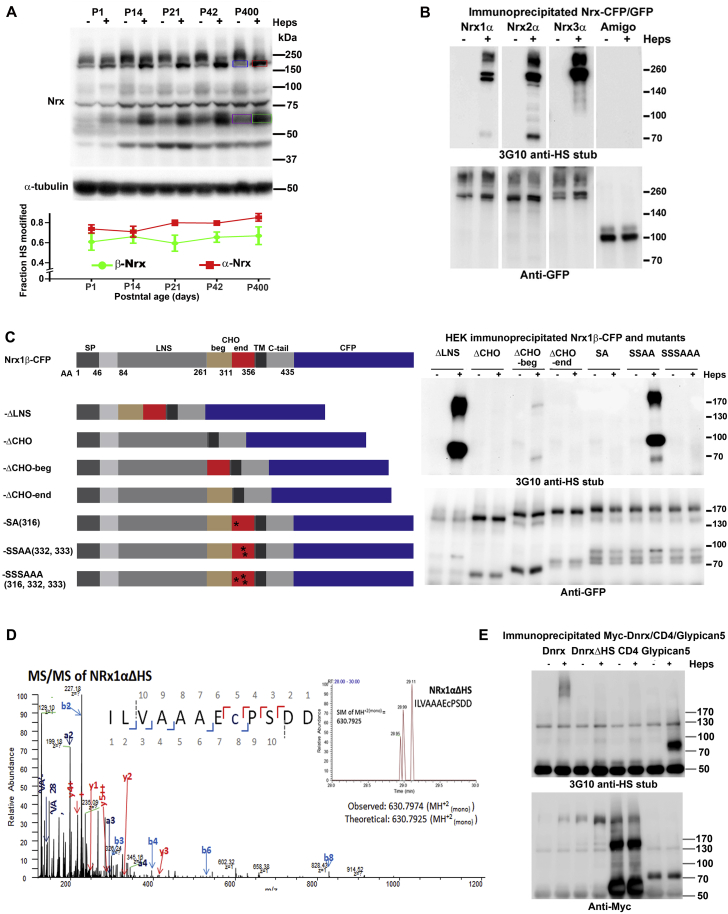
Nrxs Are HSPGs, Related to Figure 1(A) Nrx HS modification throughout development. Crude synaptosome fraction was prepared from mouse brain at the postnatal ages indicated (in days, e.g., P1 is postnatal day 1) and treated or not with heparinase. The extent of Nrx HS modification at each age was estimated from the Nrx immunoblot. For example for P400, the fraction of α-Nrx lacking HS modification was estimated as the integrated signal of unmodified α-Nrx in the untreated sample (blue box) divided by total α-Nrx (red box, condensed band for unmodified α-Nrx after heparinase). Similarly, for P400 the fraction of β-Nrx lacking HS modification was estimated as the integrated signal in the purple box divided by the integrated signal in the green box. In the graph shown, values are reported as fraction of α-Nrx or β-Nrx bearing HS modification. Two-way ANOVA revealed a significant effect of postnatal age (p < 0.05) but posthoc Bonferroni’s pairwise comparisons were not significant, n = 3. Error bars represent SEM.(B) Nrx is poorly HS modified in HEK293 cells in comparison with neurons. All recombinant Nrx fused with GFP or CFP expressed in HEK293 cells are recognized by an HS antibody, indicating some degree of HS modification; 3G10 recognizes the HS stub remaining after heparinase cleavage. However, heparinase treatment resulted in little or no shift in molecular weight, in contrast with the apparent molecular weight shifts of Nrx from the brain or primary neurons (Figures 1A–1C), indicating a deficient modification level in HEK293 cells.(C) Mapping the HS modification site. SP, signal peptide; LNS, laminin neurexin sex hormone binding protein domain; CHO, glycosylated region as previously reported (Reissner et al., 2013); CHO-beg, N-terminal half of the glycosylated region; CHO-end, C-terminal half of the glycosylated region; TM, transmembrane domain; C-tail, cytoplasmic domain; CFP, cyan fluorescent protein; ∗, serine to alanine point mutation. The Nrx1β lacked splice inserts. The constructs were expressed in HEK293 cells and lysate immunoprecipitated with anti-GFP antibody, treated or not with heparinase, then immunoblotted. 3G10 recognizes the HS stub remaining after heparinase treatment. Deletion of the glycosylated region or its C-terminal half or point mutation of serine 316 within this region to alanine (SA(316)) abolished HS modification, while deletion of the N-terminal half of the glycosylated region reduced but did not abolish HS modification.(D) Identification of unmodified peptide from Nrx1αΔHS recombinant protein. MS/MS of peptide ‘ILVAAAEcPSDD’ detected in Nrx1αΔHS. A Selected Ion Monitoring Chromatograph (SIM) of the whole mass at m/z MH+2(mono) 630.7925 with 10ppm mass tolerance is seen in the insert. Fragmentation was produced by Higher-energy collisional dissociation (HCD), resulting in y (red), b (light blue) ions, as well as a ions and internal ions (dark blue) necessary for confirmation of peptide sequence. Lower case ‘c’ refers to carbamidomethylated cysteine. This peptide was only found in its non-glycosylated form and only in the sample NRx1αΔHS. Results from the LC-MS/MS following the Glu-C and Heparinase I-III digestion showed 78% and 58% coverage of Nrx1α and Nrx1αΔHS, respectively.(E) Drosophila neurexin Dnrx is HS modified. Myc-tagged Dnrx and ΔHS mutant (LIFSGAGSGCRGDDEDECTPPFESGSGDD to LIFAGAGAGCRGDDEDECTPPFEAGAGDD) along with CD4 negative control and glypican-5 positive control were expressed in HEK293 cells. Lysate was immunoprecipitated with anti-Myc antibody, treated or not with heparinase, then immunoblotted. 3G10 recognizes the HS stub remaining after heparinase treatment.